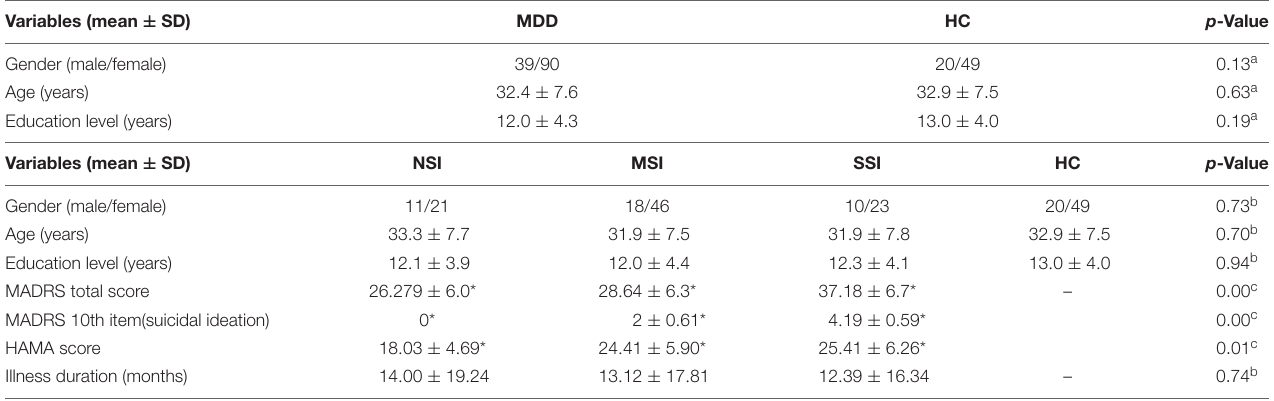
TABLE 1 | The demographics and clinical characteristics of the participants.